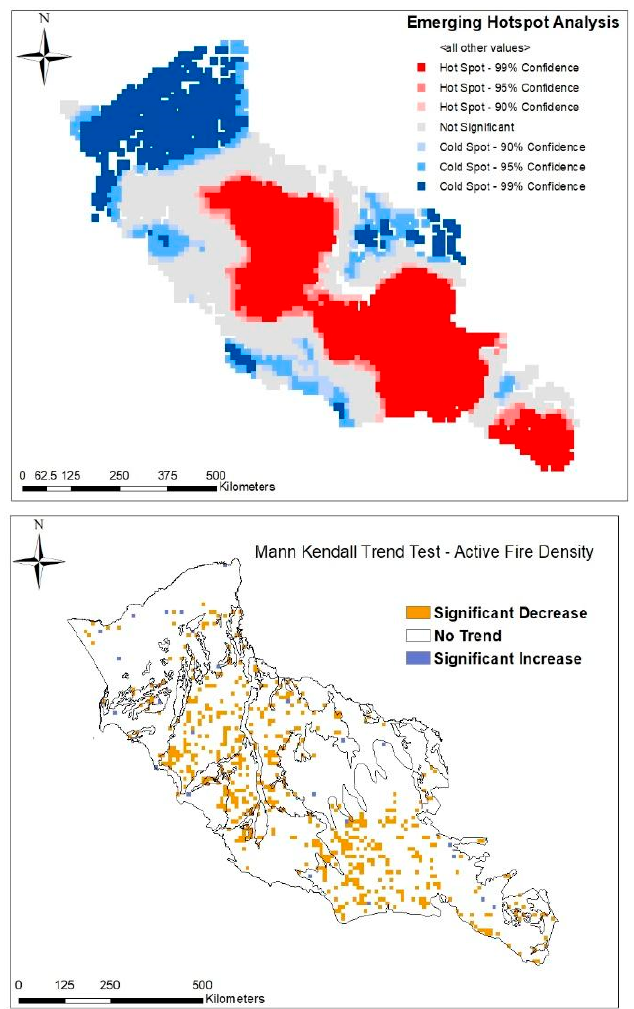
Figure 4. Emerging hotspots ( upper panel ) and Mann–Kendall trend assessments ( lower panel ).